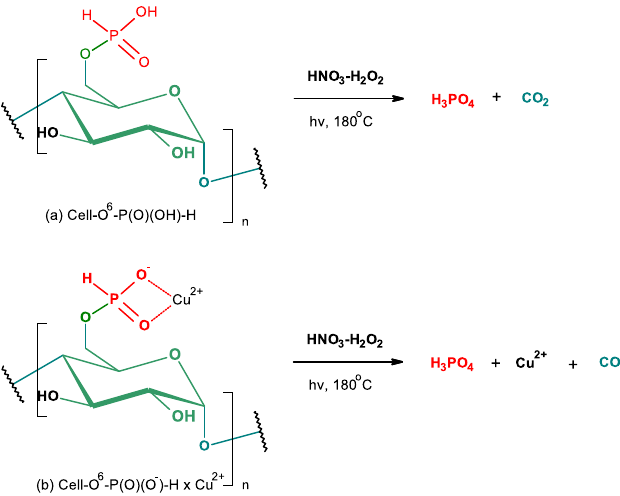
Figure 15. Digestion of ( a ) Cell- O 6 -P(O)(OH)-H and ( b ) Cell- O 6 -P(O)(O − )-H × Cu 2+ .